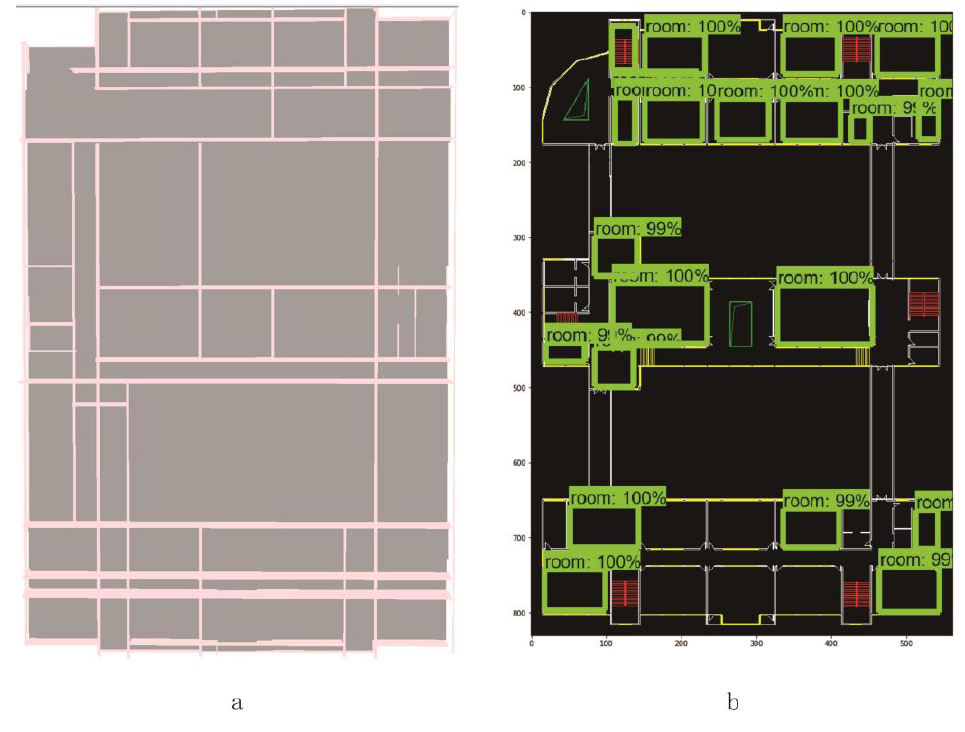
Figure 11. Illustration of navigation extraction result between geometric method and deep learning method for CAD